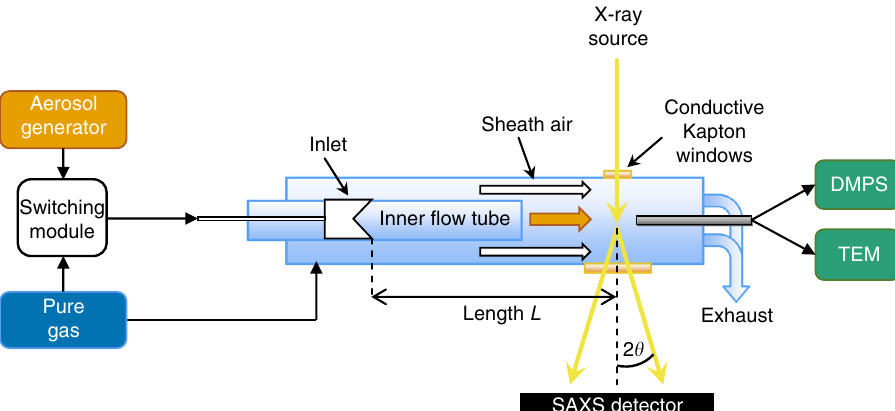
Fig. 1 Schematic drawing of the fl ow tube reactor at the SAXS beamline. Either particle-laden air from the aerosol generator or pure air is injected through the moveable inlet into the inner fl ow tube. The sheath air system and the conductive Kapton are precautions against particle deposition on the windows. The particles are measured on the one hand with the SAXS system and on the other hand with conventional aerosol measurement techniques (DMPS and TEM) after core